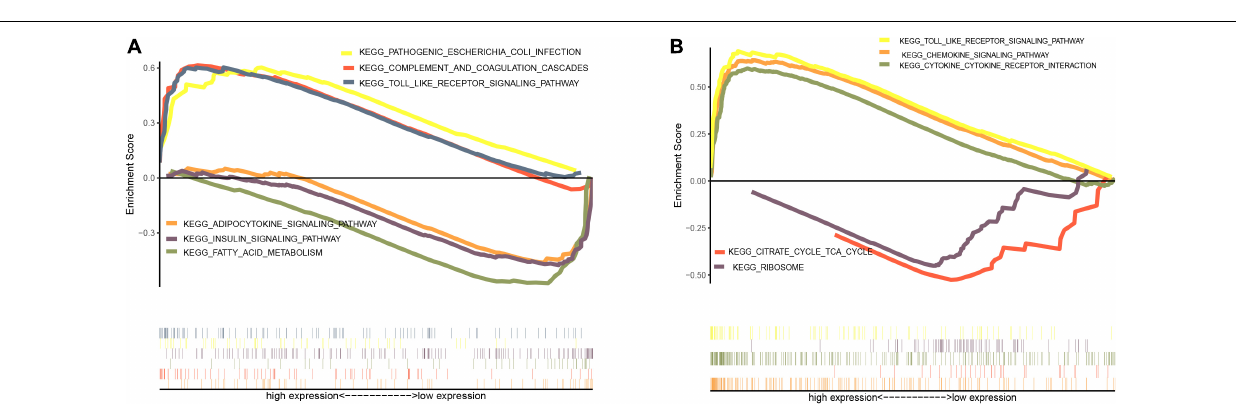
FIGURE 3 | Enrichment analysis of gene set pathway. (A) Gene set enrichment analysis in GSE70353. (B) Gene set enrichment analysis in